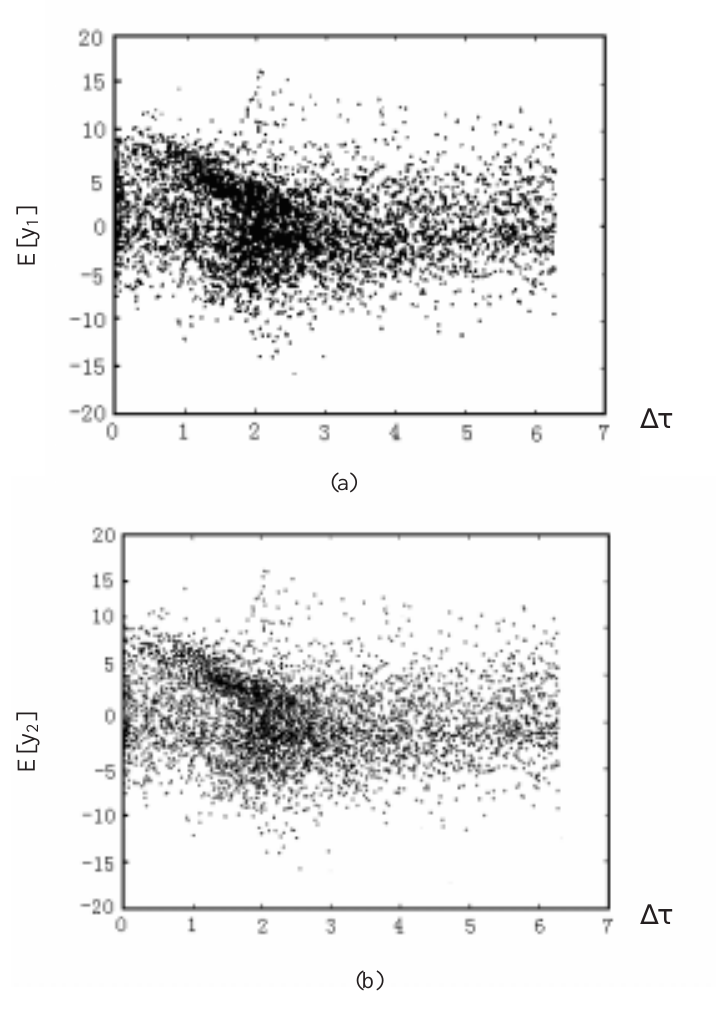
Fig. 2. the mean poincar´e map. E [ y 1 ] ,E [ y 2 ] – mean velocity; ∆ τ – time